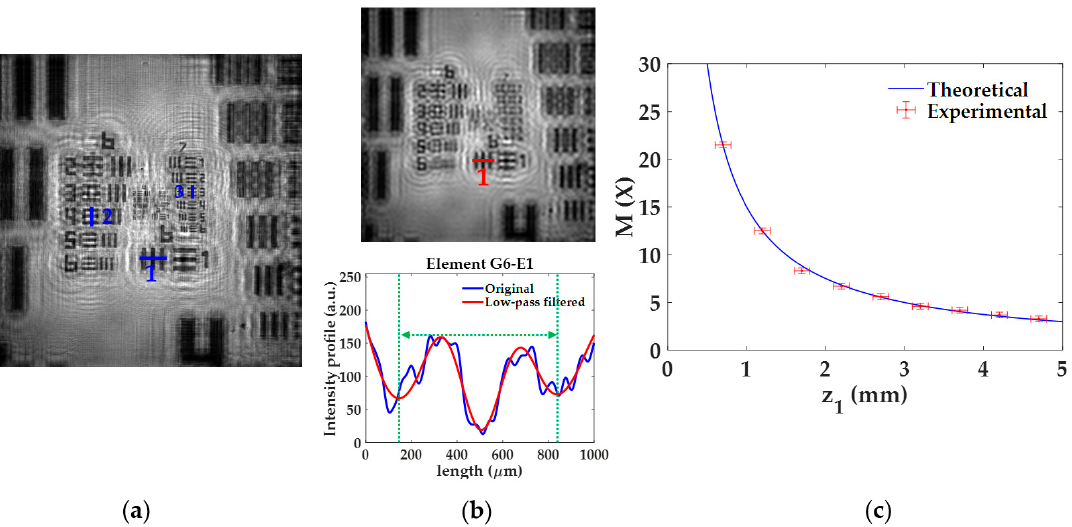
Figure 3. Experimental procedure for the analysis of the lateral magnification M . ( a ) Retrieved intensity image for a distance z 1 = 0.7 ± 0.1 mm; ( b ) low-pass filtered image of ( a ) (upper part) and comparison between intensity profiles for better obtention of M values (bottom part); ( c ) calibration curve of M with the distance z 1 including experimental and theoretical values.